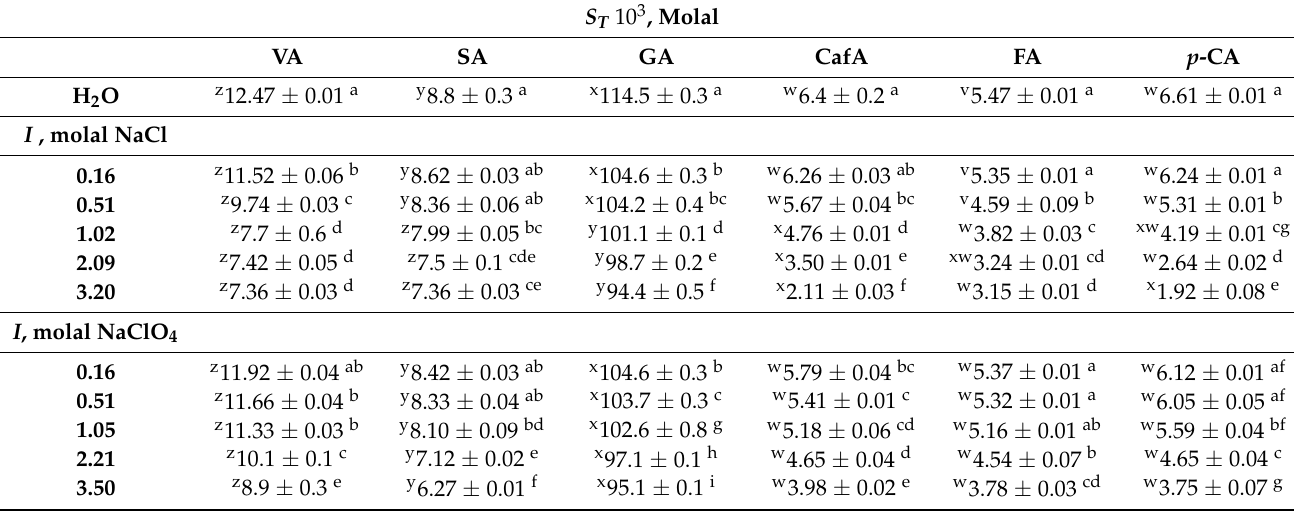
The values with different superscripts (a, b, c, d, e, f, g, h and i) in the same column are significantly different ( p < 0.05). The values with different superscripts (v, w, x, y and z) in the same row are significantly different ( p < 0.05).